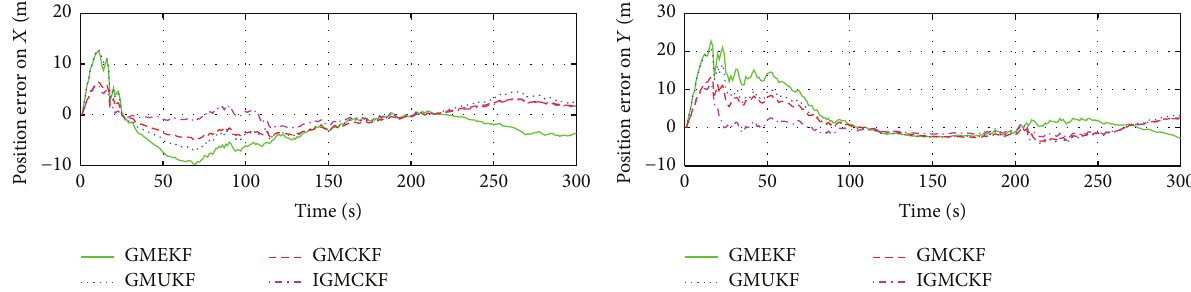
Figure 3: The curve of position error in 𝑋 and 𝑌 .